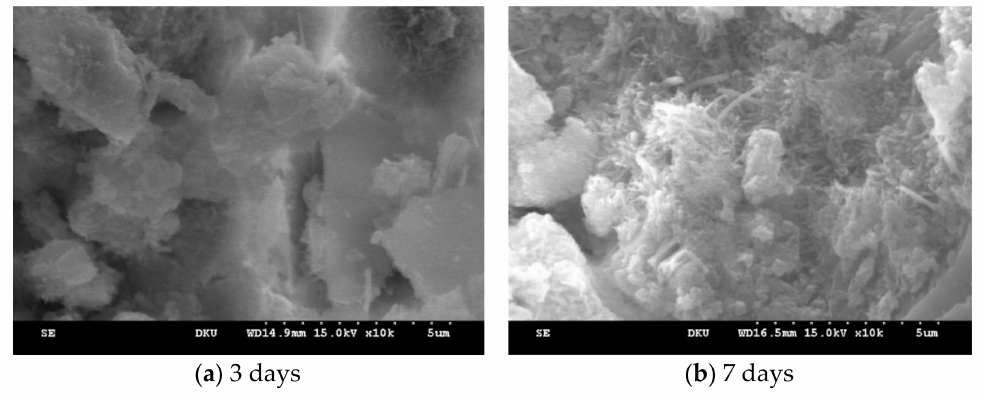
Figure 10. Microstructure characteristics (conventional gang form).